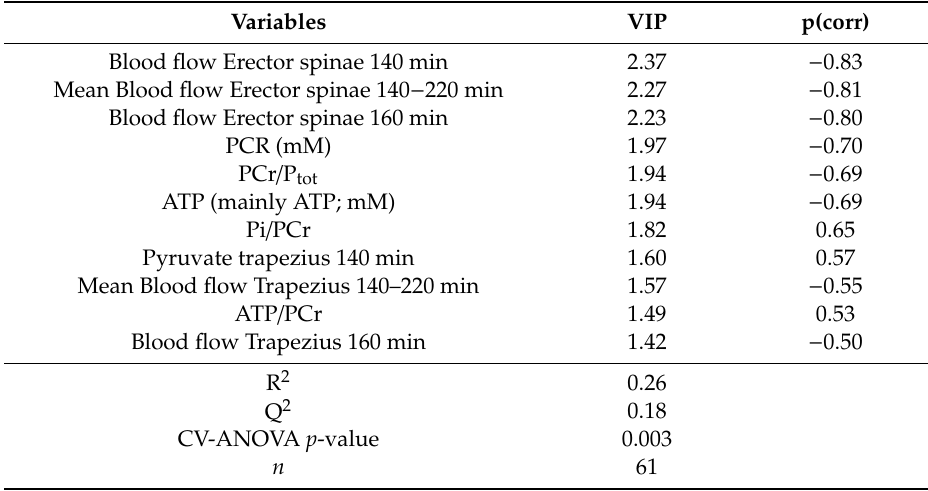
Table 5. OPLS-DA of group membership (CON denoted 0 and FM denoted 1). Regressors used data from spectroscopy and microdialysis (except pain variables from microdialysis) (cf. Tables 3 and 4). The regression had one predictive component. Only significant variables are shown (i.e., variables with VIP > 1.0 and absolute p(corr) ≥